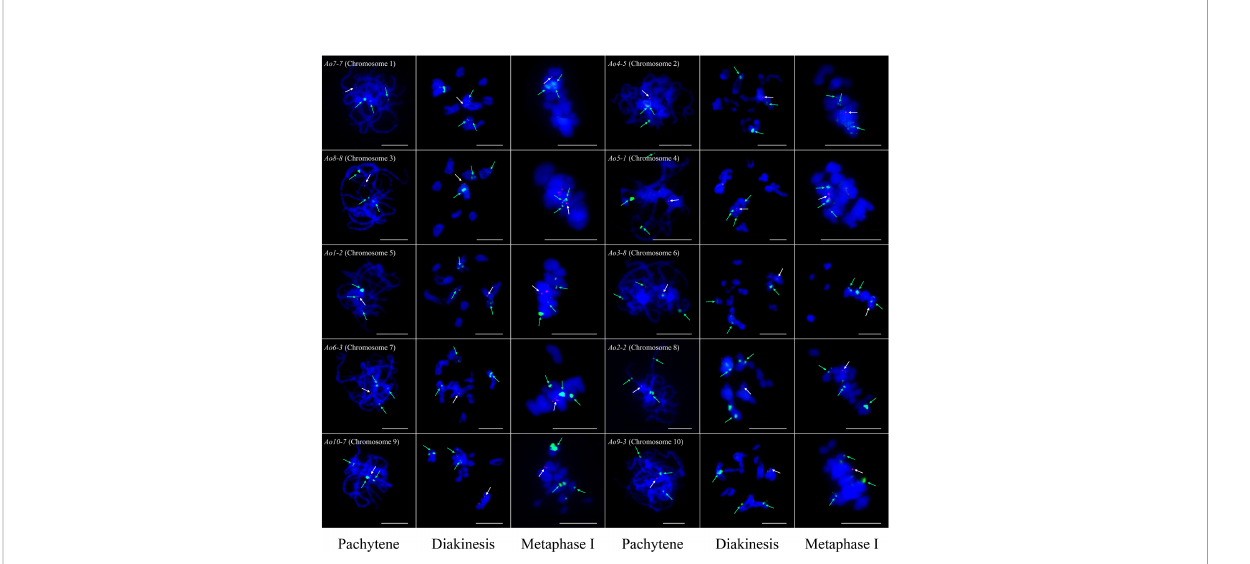
FIGURE 4 Single copy gene-based FISH analysis on meiotic chromosomes at different stages in garden asparagus. The white arrows denote the chromosome-speci fi c FISH signal (red). The green arrows denote the signals of 45S rDNA (green). Bars = 10 m